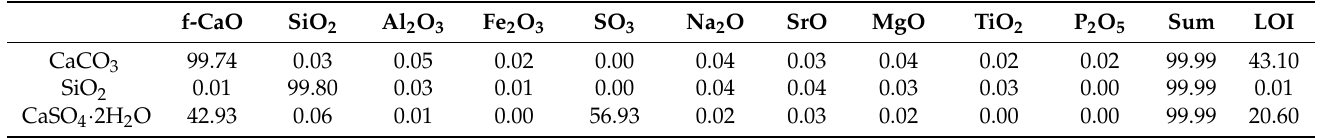
Table 1. Chemical composition (XRF) of raw materials used to prepare ternesite, expressed as wt% of oxide; LOI = loss of ignition at 1100 ◦ C. When the total content (except LOI) is not equal to 100 wt%, the remaining 0.01 wt% is the total content of other trace